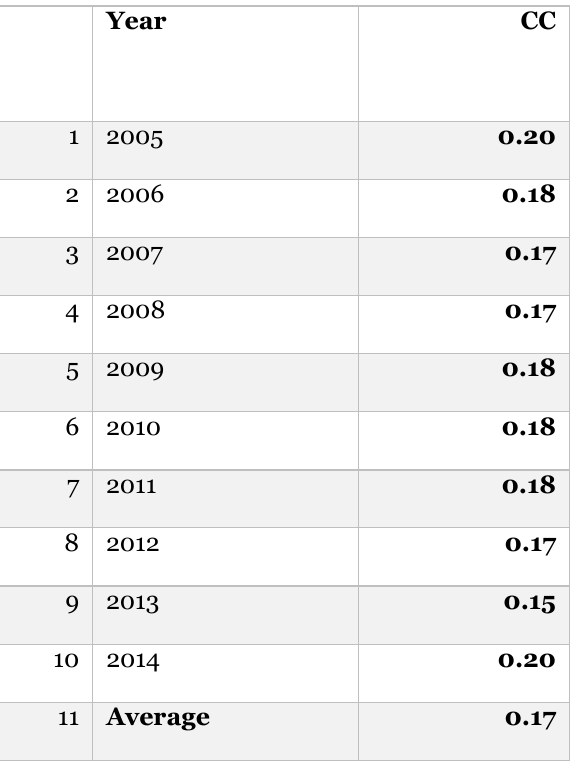
Collaborative Coefficient in the E-learning Area,